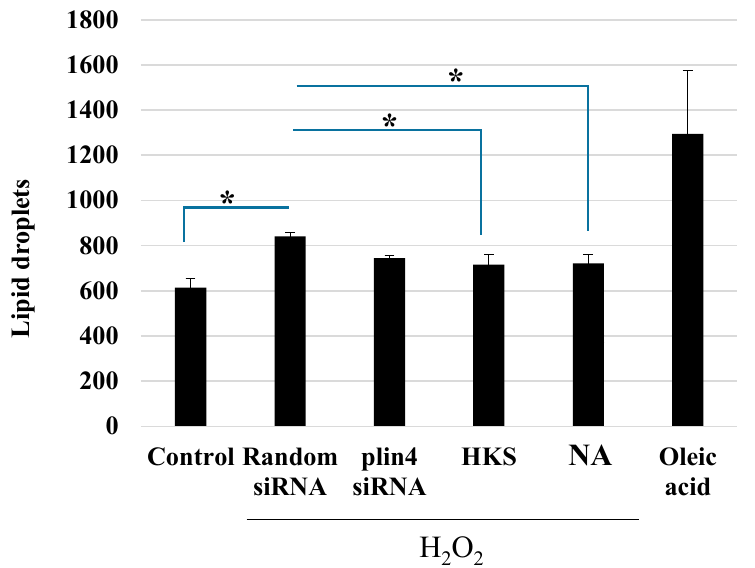
Figure 4. Bifidobacterium breve MCC1274 extracts and niacin suppress lipid droplet formation in SH-SY5Y cells. The SH-SY5Y cells were exposed to siRNA (random siRNA or PLIN4 siRNA), HKS ( B. breve MCC1274 heat-killed cell extracts, 1% final v/v), or NA (100 nM) in the presence of H 2 O 2 (200 µ M) for 24 h and then stained with BODIPY (2 µ M). Untreated cells were used as a control. Oleic acid (60 µ M) was used as a control to confirm the induction of lipid droplets. The y -axis shows the FITC signal as measured by flow cytometry. The data are shown as the mean + SD of three replicates. * p < 0.05 (Student’s t-test for two-group or non-repeated measures ANOVA with the Bonferroni post hoc test for multiple-group comparison,